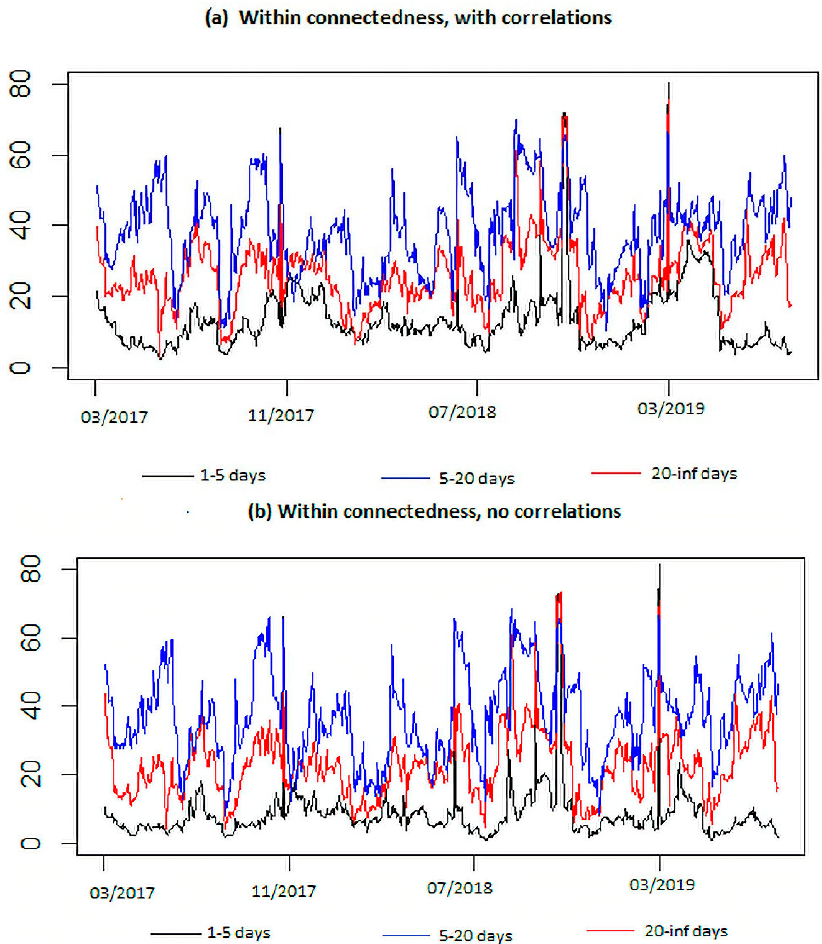
Figure 5. Within scale connectedness between bitcoin, gold, and crude oil return volatilities. Note: